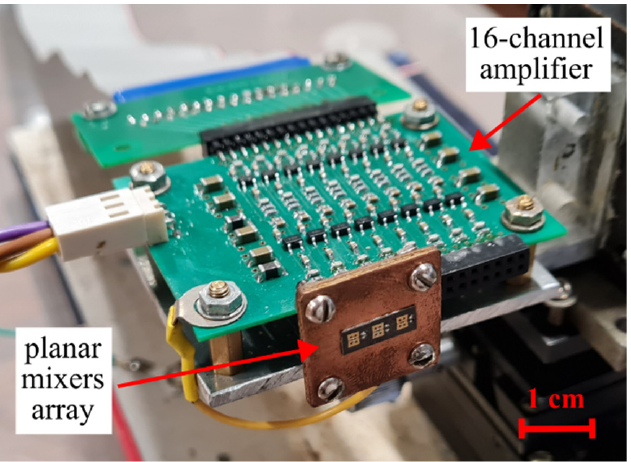
Figure 3. A photograph of the 1 × 3 array receiver. The receiver consists of a planar mixers array and a multi-channel transimpedance amplifier.